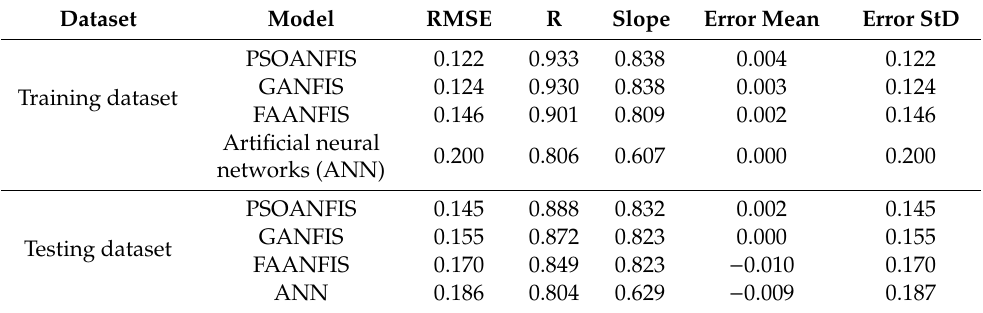
Figure 6. Error analysis of the models using the training dataset: ( a ) probability distribution and ( b ) cumulative distribution; using the testing dataset: ( c ) probability distribution and ( d ) cumulative distribution. Table 3. Summary of prediction capability of four artificial intelligence (AI) models.